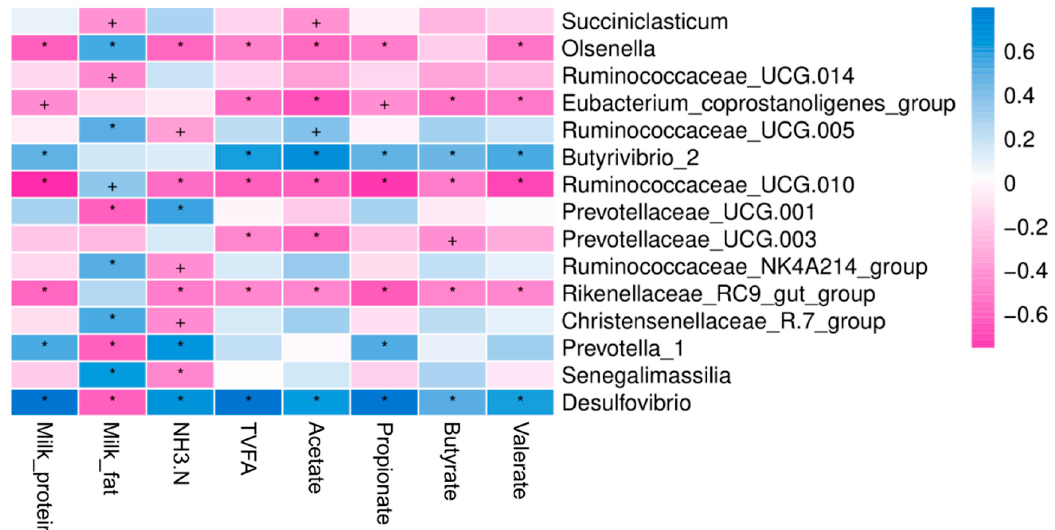
Figure 5. Spearman correlation and clustering analysis between milk composition, ruminal fermentation parameters, and main bacteria at genus level. The depth of the color indicates the correlation between species and environmental factors. TVFA: Total volatile fatty acids, NH 3 -N: ammonia nitrogen. The “+” and “*” indicates the different level at 0.05 and 0.01, respectively.